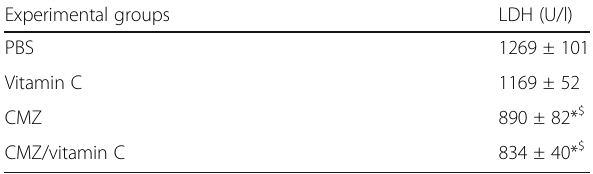
Table 6 Ex vivo anti-proliferative effects of vitamin C (113.6 μ M/ well), clomazone (CMZ) (4.6 μ M/well), or a combination of CMZ and vitamin C with the same dose of each for 48 h on murine